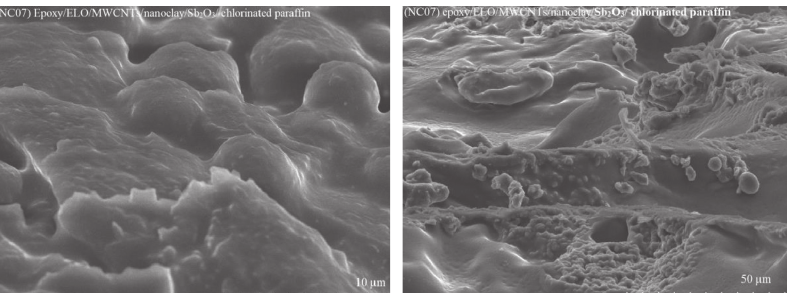
Figure 5: FE-SEM of the sample nanocomposites: epoxy Epikote 240/nanoclay/MWCNTs/epoxidised linseed oil/Sb paraffin.